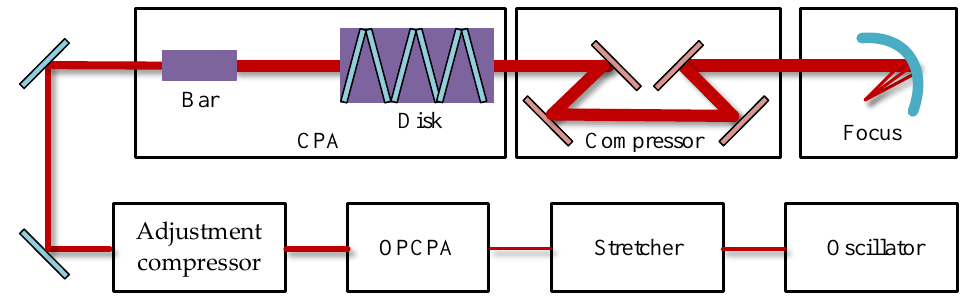
Figure 2. Block diagram of the existing SG PW laser system.